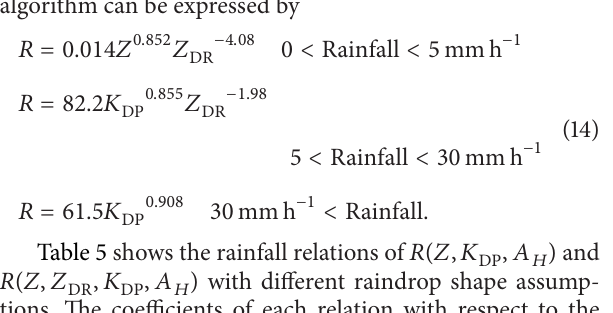
,𝐾 , 𝐴 ) with different raindrop shape 𝐻 DR DP